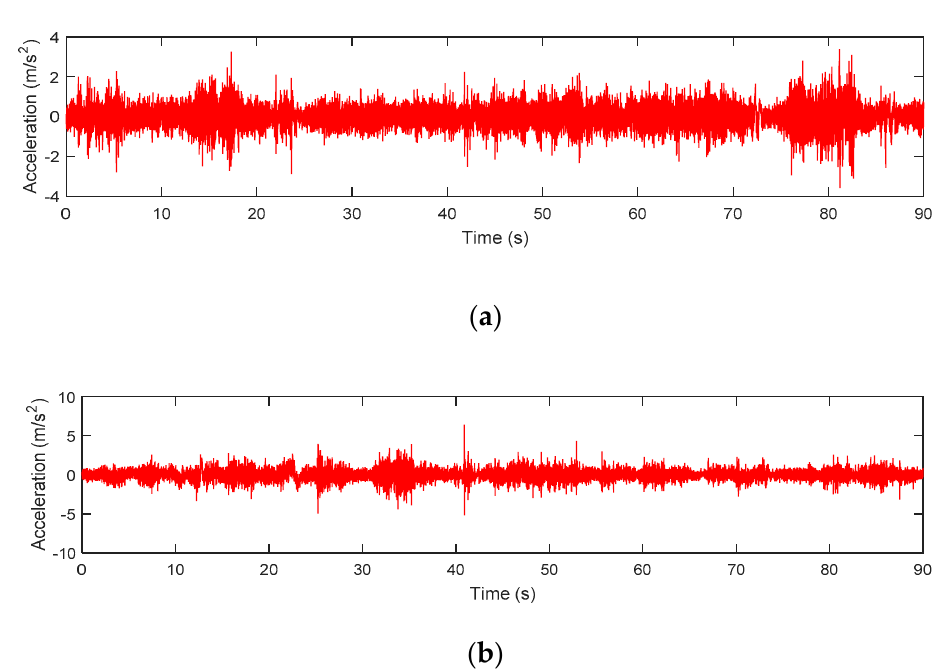
Figure 9. Measured strain signals: ( a ) Highway A, ( b ) Highway B.